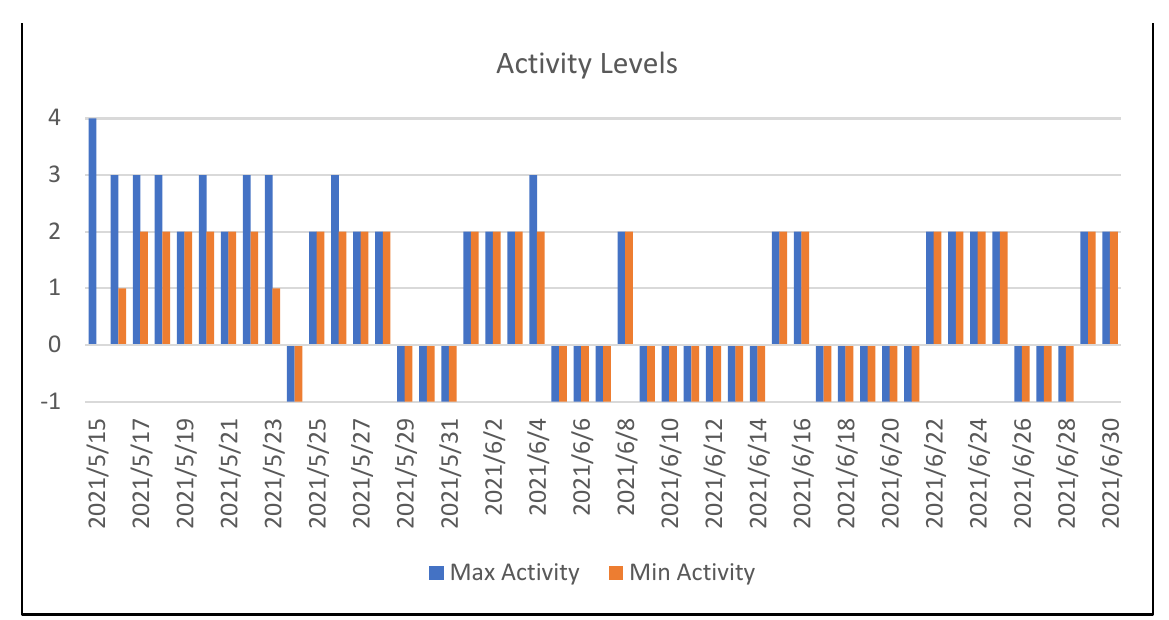
Figure 12. This figure shows the maximum and minimum activity values recorded each day for the